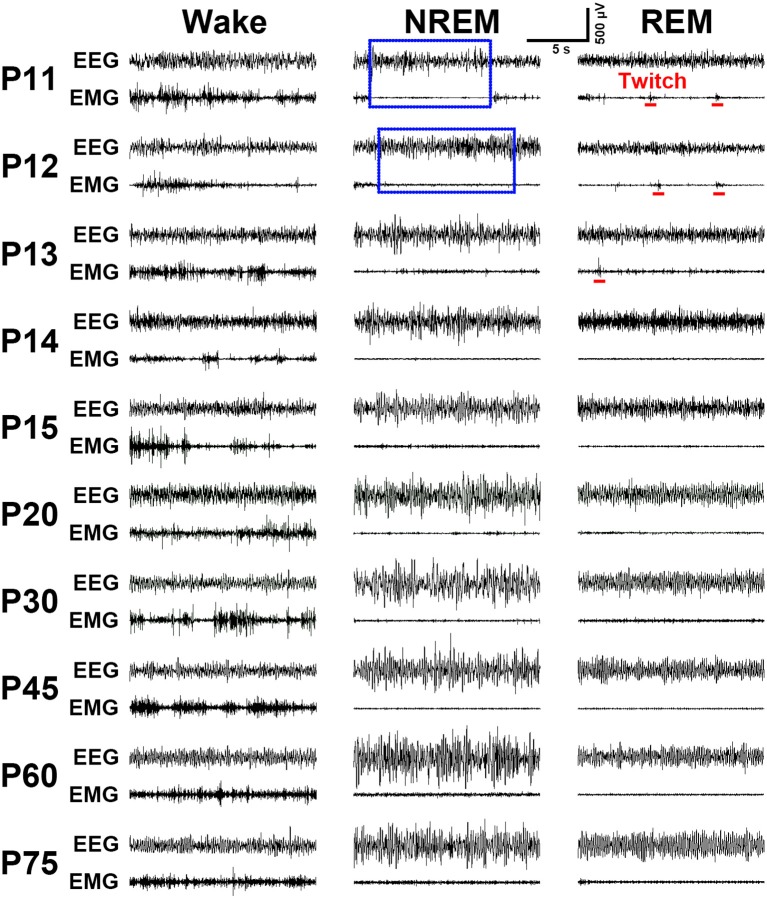
Evolution of EEG and EMG activities in wake, NREM and REM sleep from P11 to P75 rats. Note the EMG bursts during REM sleep denoting the presence of muscular twitches (red bar) in P11-P13 pups. Calibrations: 500 μV, 5 s.